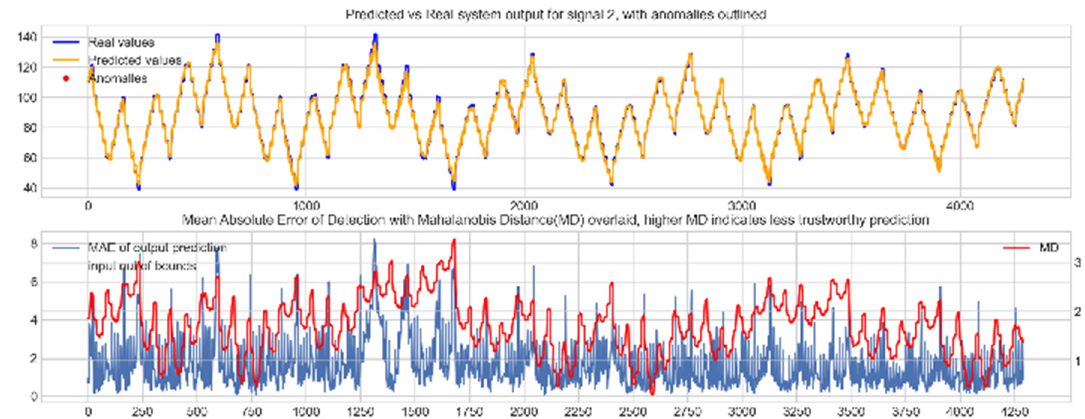
Figure 7. Predicted vs. Real NN prediction for output signal 2, the left elevon.